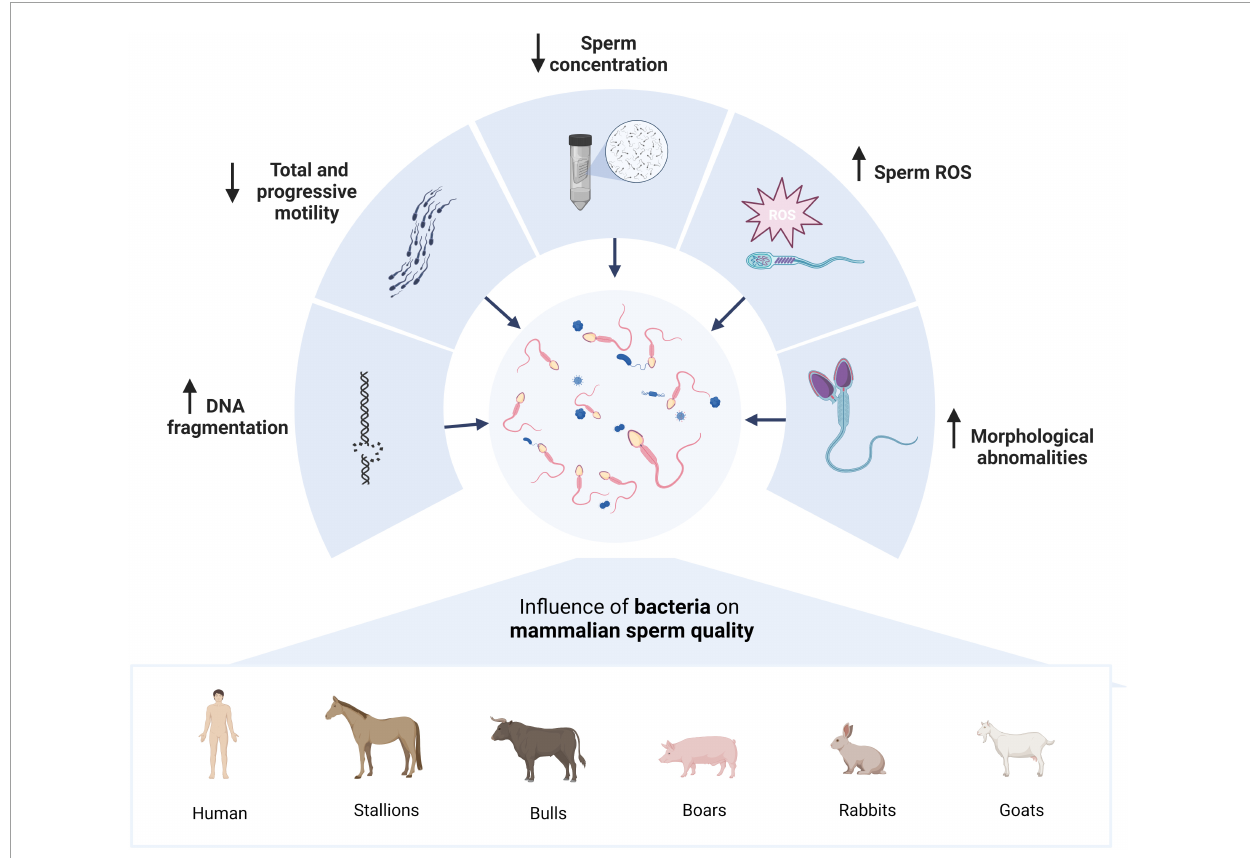
FIGURE2 Effects of the relationship between mammalian spermatozoa and the microbiota. Several studies report similar effects on mammalian semen quality parameters such as DNA fragmentation, decreased sperm concentration and progressive and total motility, and increased ROS concentration and morphological abnormalities. Created with